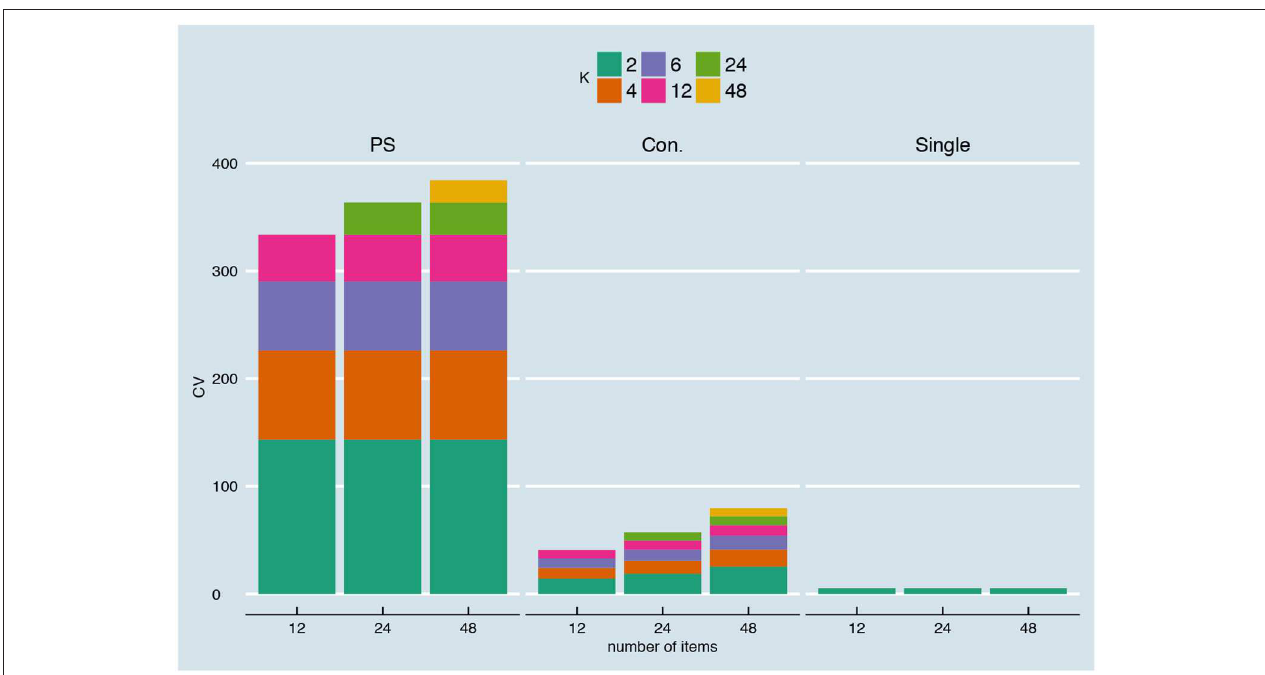
FIGURE 15 | Coefficient of variation (see Equation 26) for different number of items, for the relationship depicted in Figure 5A and with continuous parallel test scores.